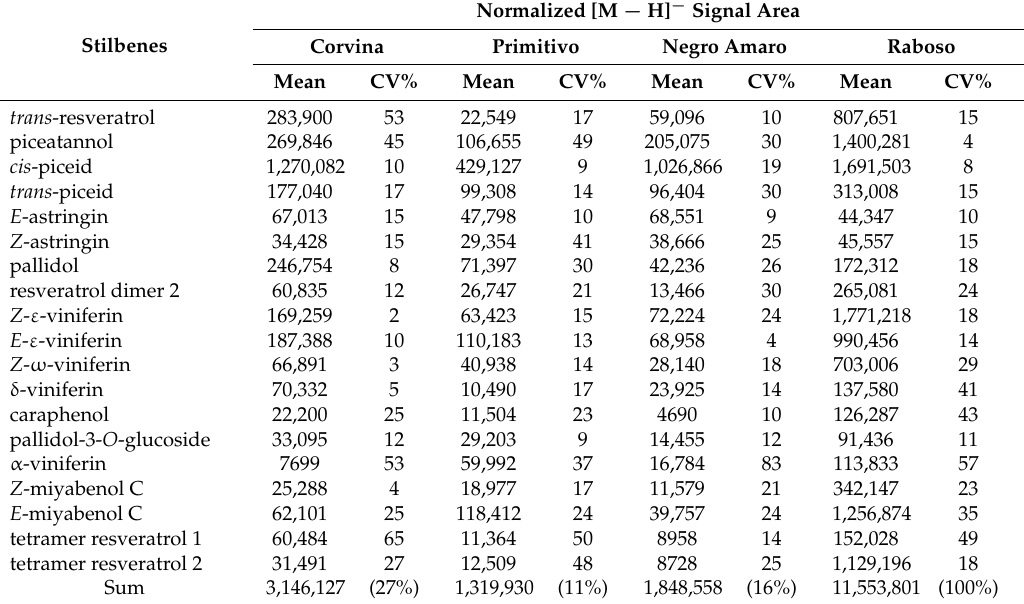
Table 5. Normalized LC-Q/TOF signal intensities of resveratrol derivatives identified in the grape varieties studied. CV%, coefficient of variance (SD × 100/mean, n = 4). In the last line, the percentages of the total signal normalized to Raboso Piave samples are reported in bold. n.f., signal not found. Normalized [M − H] − Signal Stilbenes